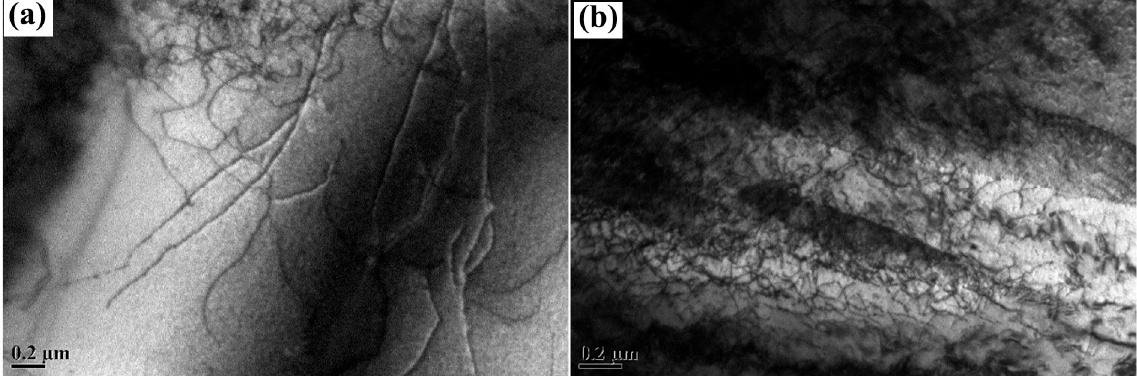
Figure 10. Dislocation con fi guration of test steel at di ff erent coiling temperatures: ( a ) 650 °C; ( b ) 600 °C.